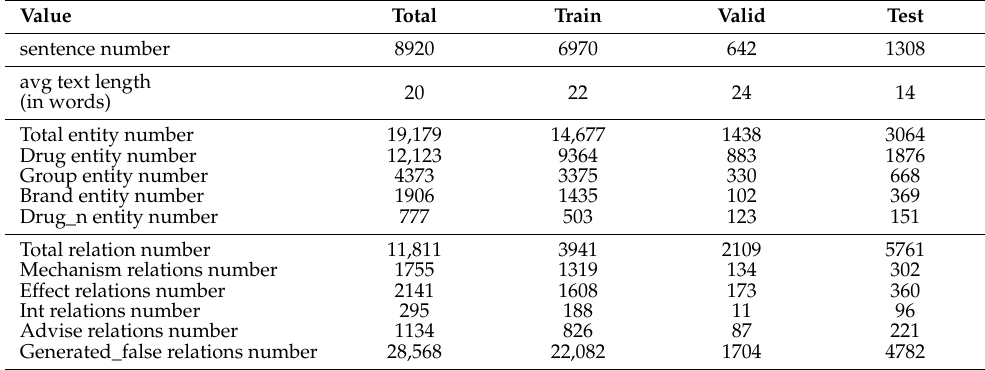
Table 4. DDI dataset information. BLURB